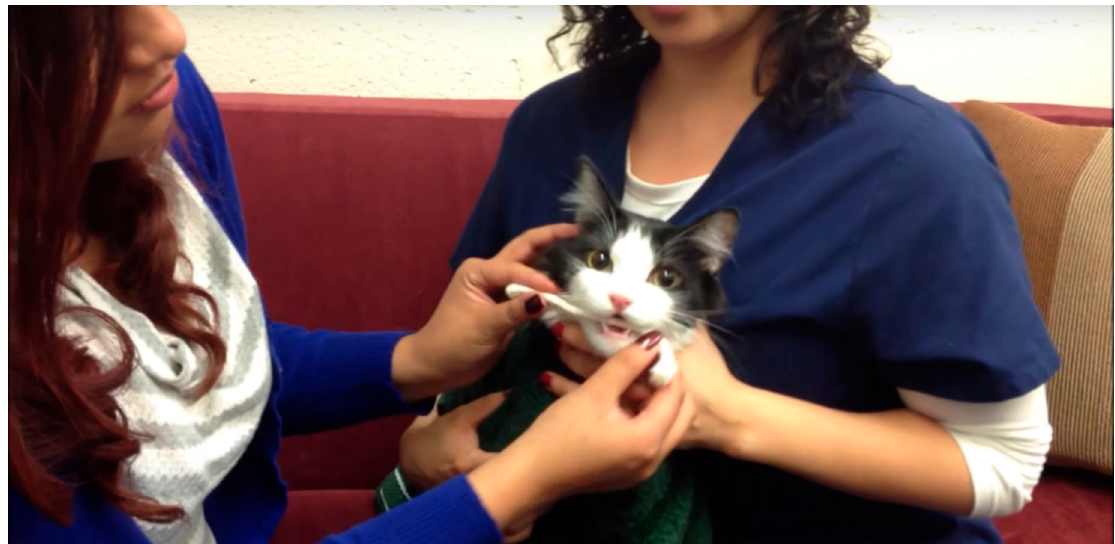
Figure 1. Collecting saliva from a cat for food intolerance testing.